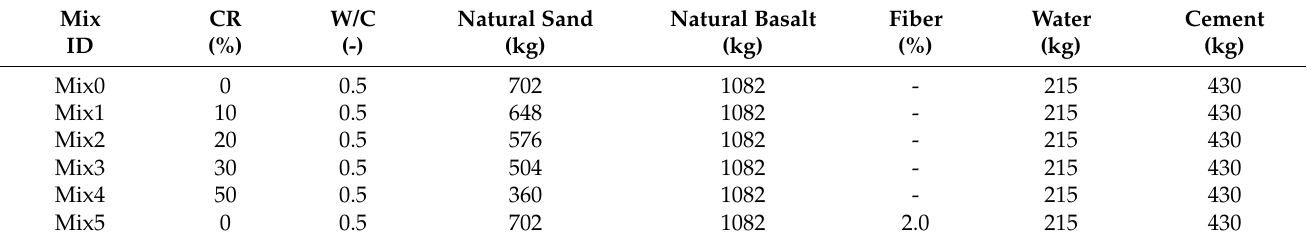
Table 3. Mix proportion for 1 m 3